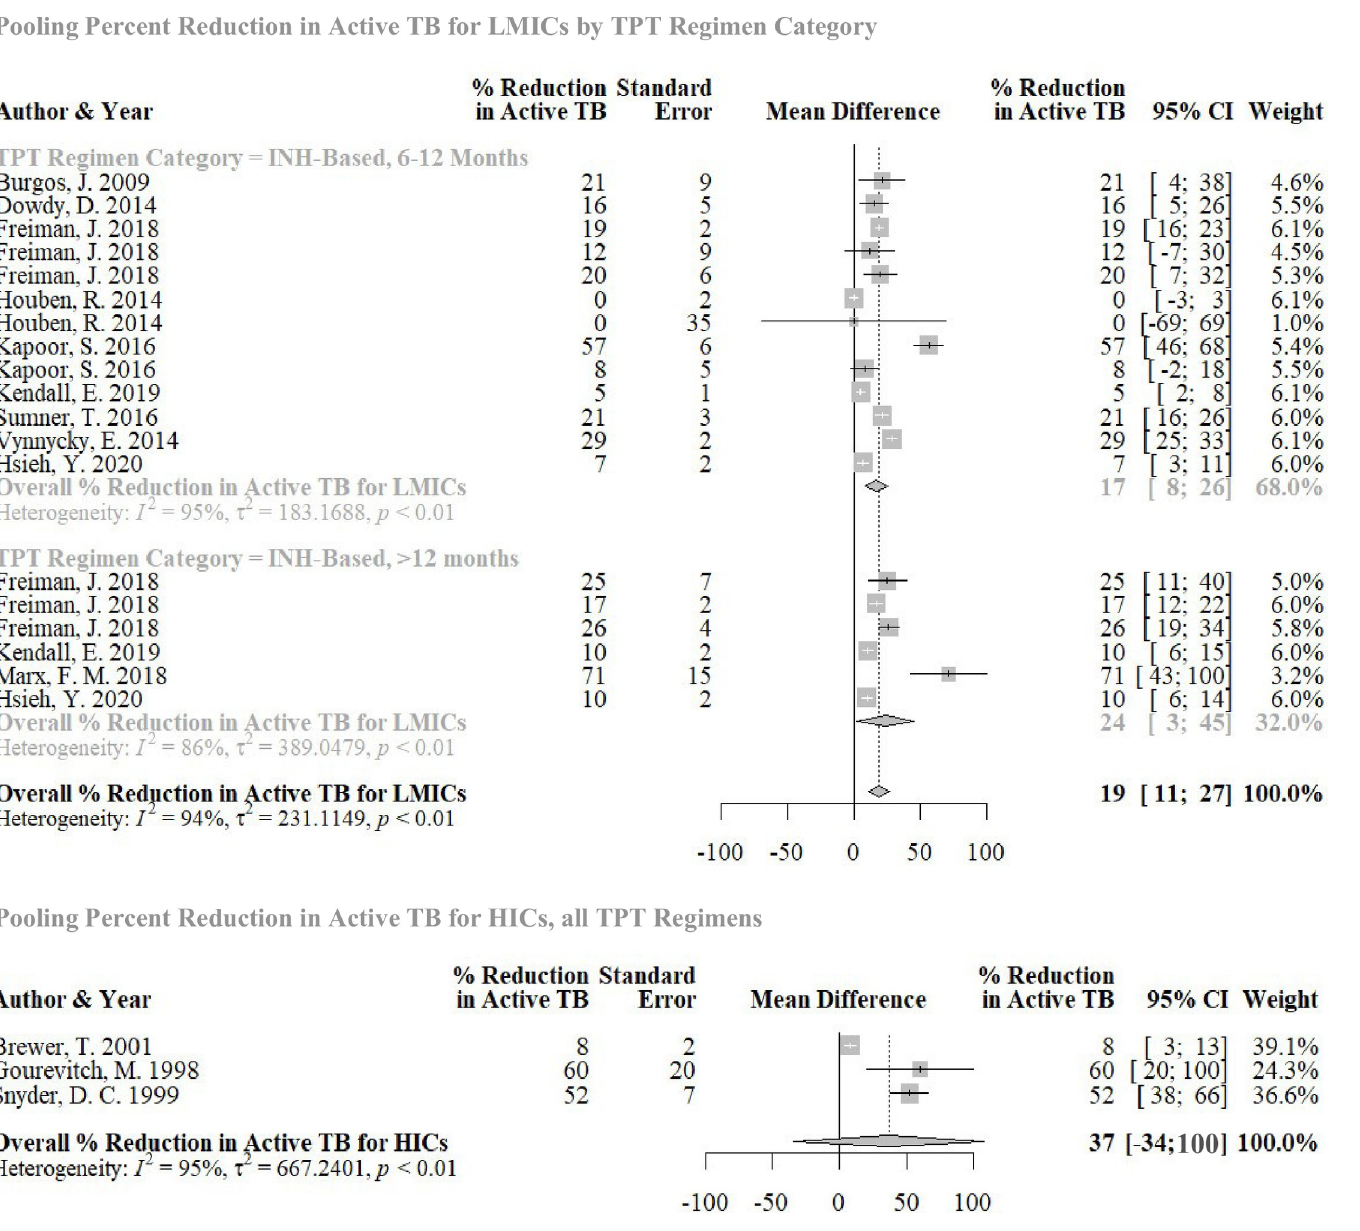
Fig 5. Forest plot: percent reduction in active TB in studies comparing TPT to no TPT, by groups of regimens and country income level. CI, confidence interval; HIC, high-income country; INH, isoniazid; LMIC, low- and middle-income country; RIF, rifampin; TB, tuberculosis; TPT, tuberculosis preventive therapy. No subgroup analyses done for HICs to small number of studies. No RIF-based regimens included in LMICs that had sufficient information for pooling.